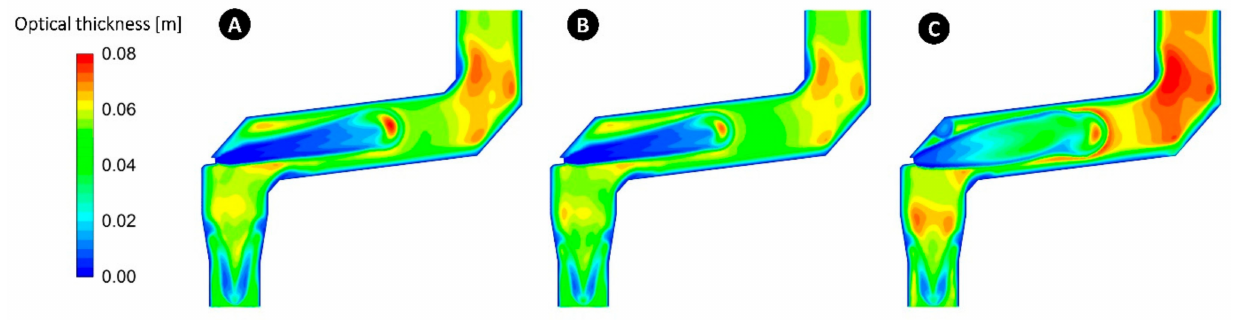
Figure 19. Predicted optical thickness for different radiation model of DOM ( A ), P1 ( B ), and Rosseland ( C )